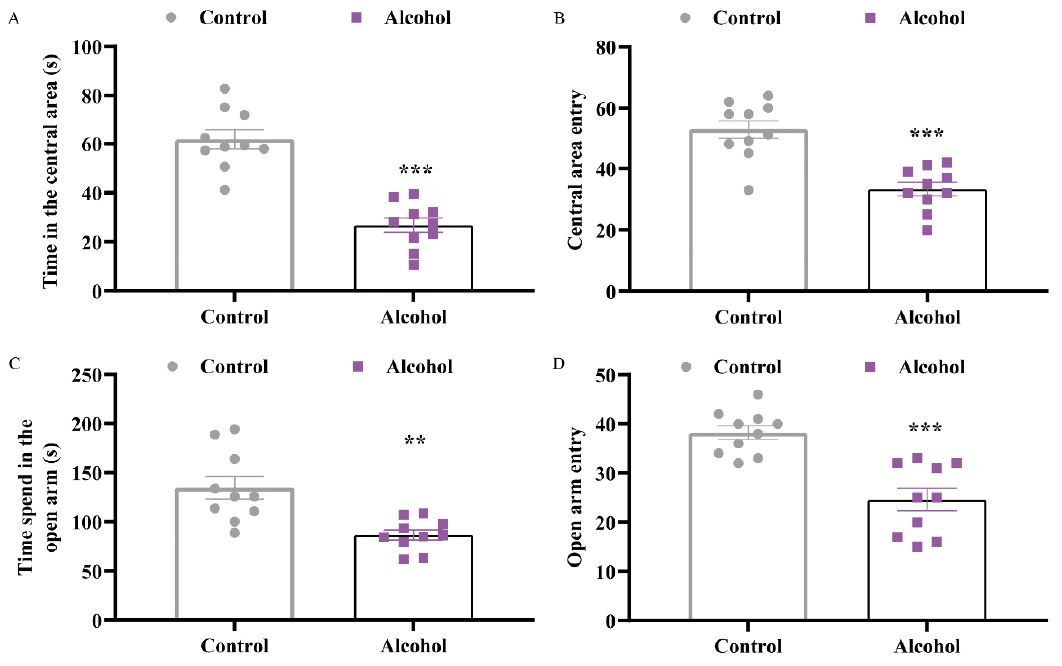
Figure 2. Alcohol exposure induced anxiety-like behaviors in mice. ( A ) The time of central area entries in open field test, ( B ) the time in the central area in open field test, ( C ) the number of entries in the open arms in zero maze test, and ( D ) the time spent in the open arms in zero maze test. Data are presented as the mean ± SEM, n = 10 for per group. Statistical analyses were carried out by Student’s t test, ** p < 0.01, *** p < 0.001 vs. control group.